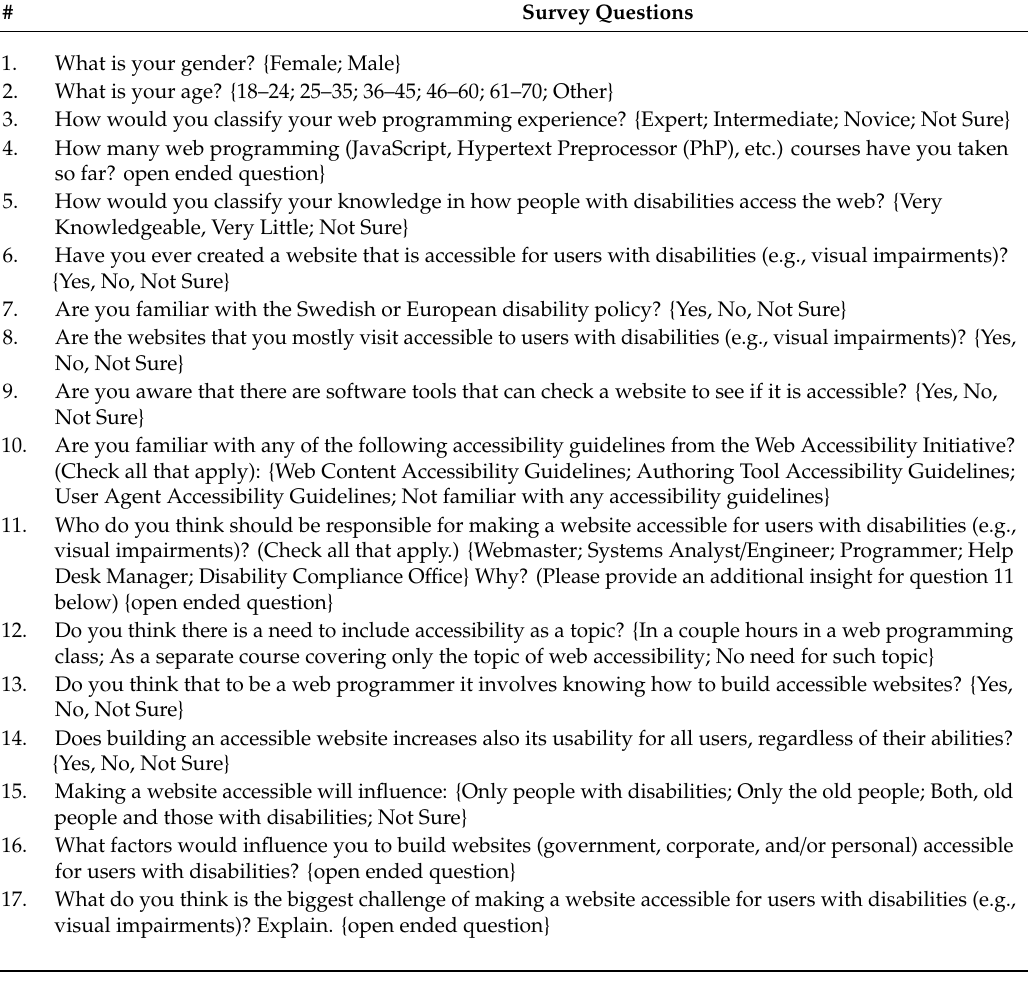
Table 3. Survey questions.